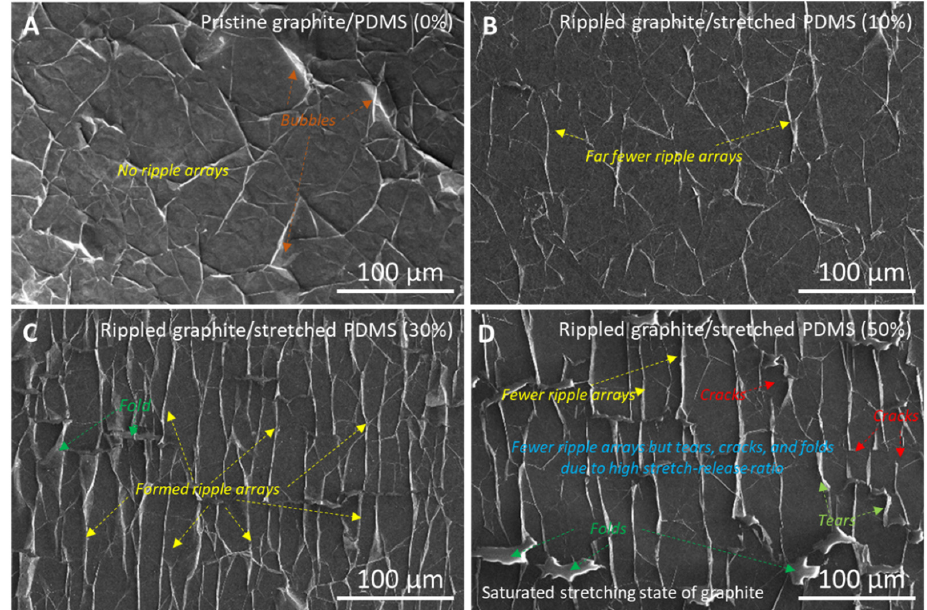
Nanomaterials 2021 , 11 , x FOR PEER REVIEW Figure 2. SEM images of ( A ) pristine graphite/PDMS (0%), ( B ) rippled graphite/stretched PDMS (10%), ( C ) rippled graphite/stretched PDMS (30%), and ( D ) rippled graphite/stretched PDMS (50%).